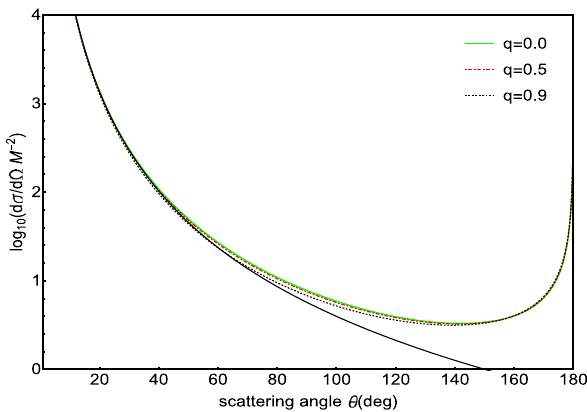
Fig. 1 Classical scattering cross section of GMGHS black holes, with q = 0 , 0 . 5 and 0.9. The black solid line is given by Eq. (11), with q = 0